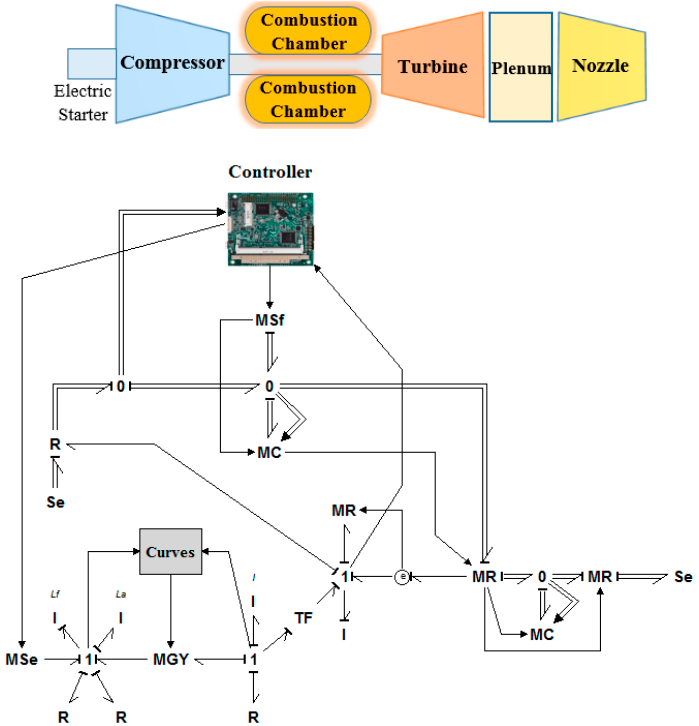
Table 1. JetQuad specifications.